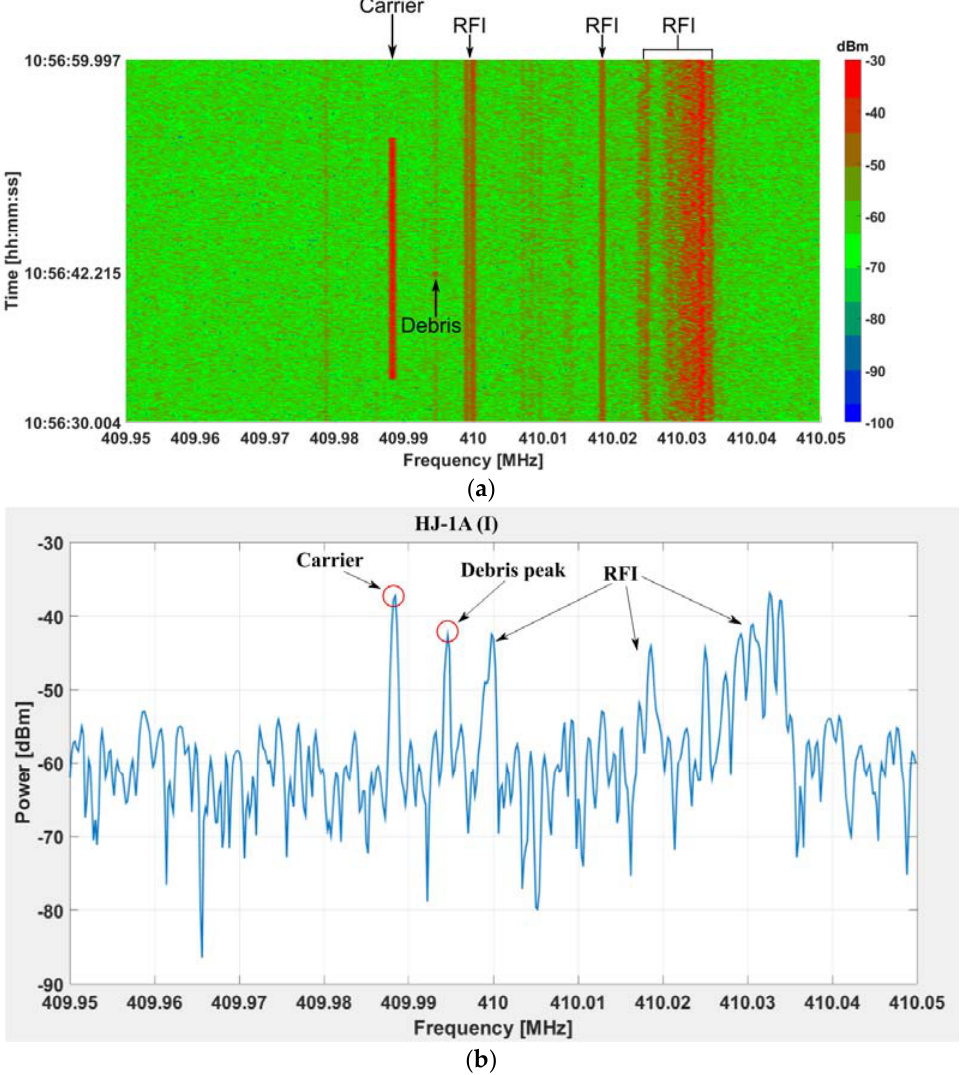
Figure 5. Debris HJ ‐ 1A (first passage): ( a ) spectrogram; ( b ) screenshot of the spectrum analyzer at the center of the visibility interval (Table 4).